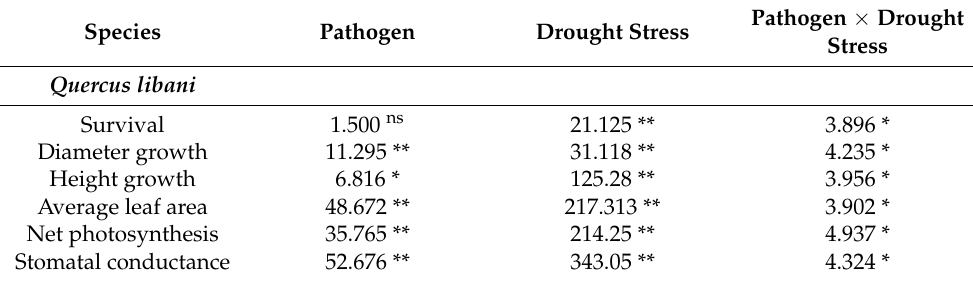
Table 1. Two-way ANOVA results for parameters measured in Quercus libani and Q. infectoria seedlings inoculated with charcoal disease agents ( O. persica or B. mediterranea ) and subjected to drought stress (100% of field capacity or 20% of field capacity). Degrees of freedom ( df ) for drought stress = 1, pathogen = 2 and pathogen × drought stress = 2. Although all the photosynthesis parameters, WUE and RWC were statistically analyzed for each of the three measurement campaigns, represent F -values of ANOVA